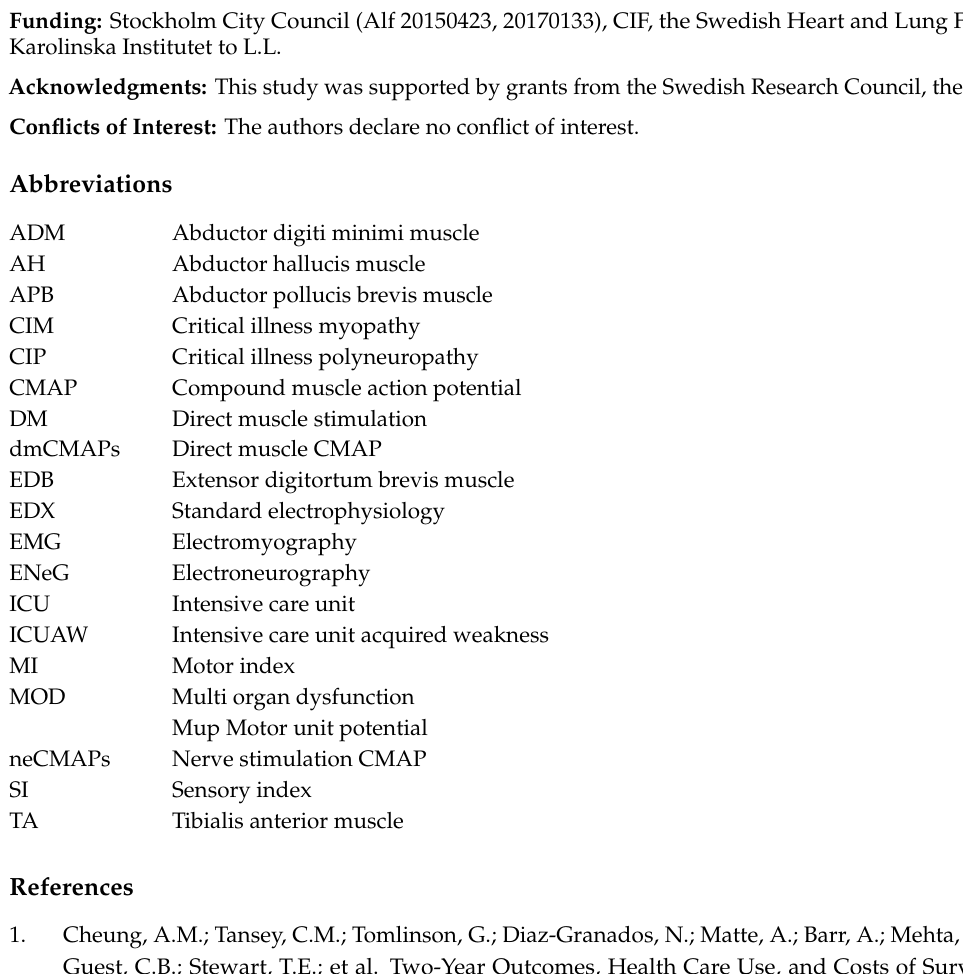
Figure S1: Myosin:actin ratios at five di ff erent protein concentrations, Figure S2: Scatterplots of CMAP index, SNAP index, mCMAP amplitude, nCMAP amplitude, refractory period and signal duration vs. myosin:actin ratio, Table S1: Myosin:actin ratios in healthy control